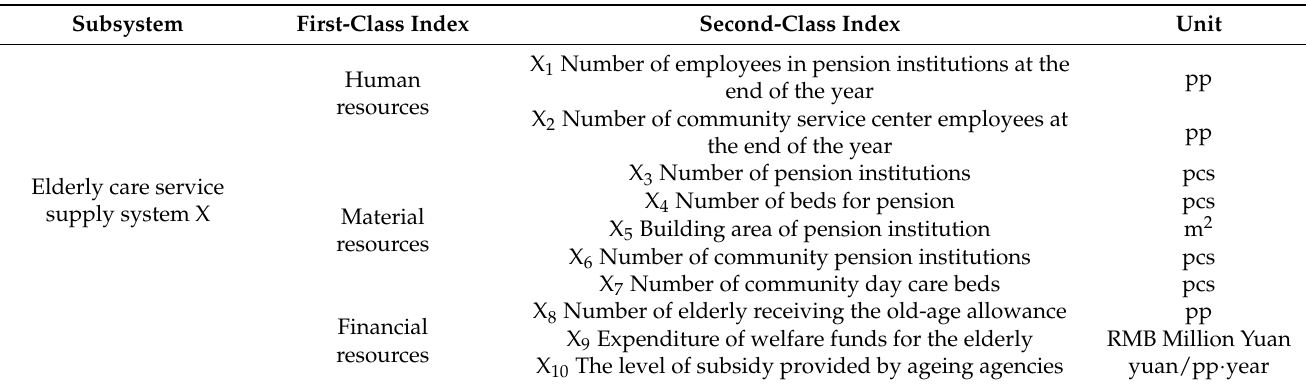
Table 1. Indexes of elderly care service supply system.